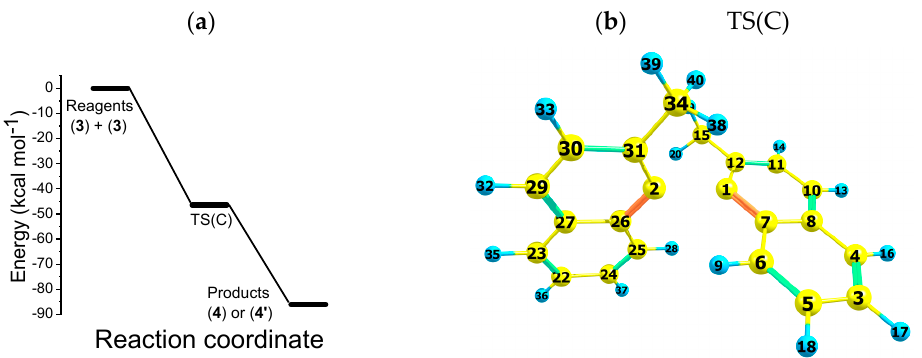
Figure 3. ( a ) Potential energy surface for reaction path C, at the UB3LYP/cc-pVTZ level of theory. Gibbs free energy of reagents ( 3 ), final products (4) and transition state ( TS ( C ) ) ( b ) Bonds used to characterize the formation of the dimer: C 1 − C 2 1,1 (cid:48) -binaphthalene, 2,2 (cid:48) -dimethyl. The energy levels were normalized to the energy of state ( 3 ), which corresponds to a − 532,900.6507 kcal mol − 1 absolute value.